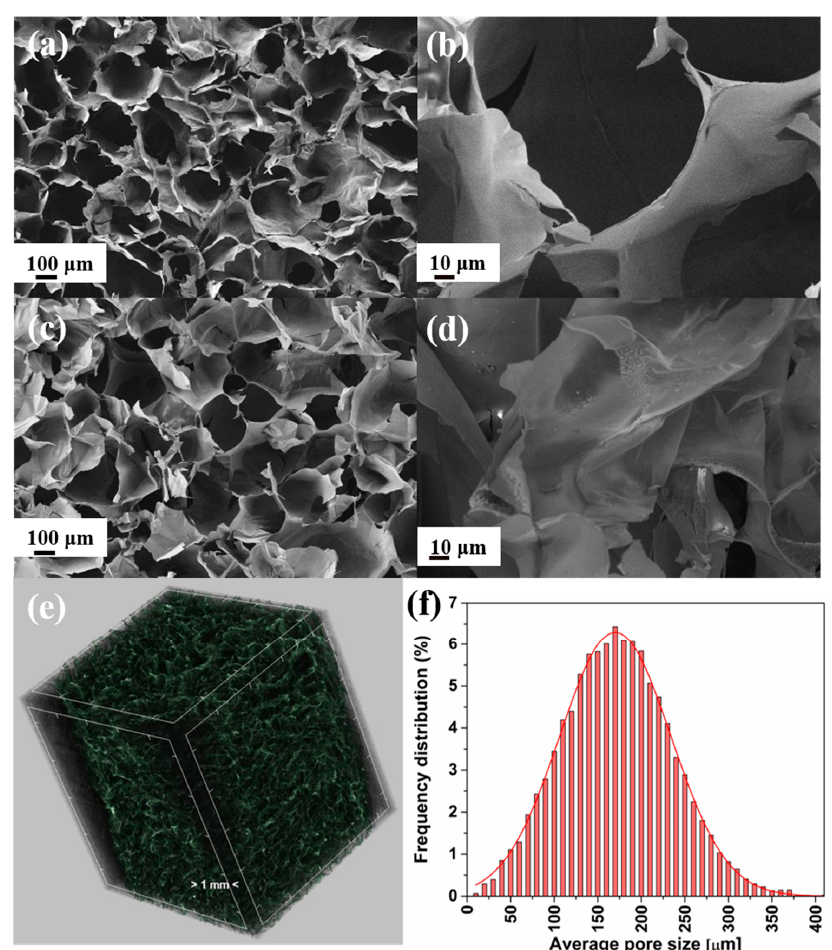
Figure 4. ( a , b ) SEM micrographs of KS sponge and ( c , d ) Ag@KS sponge at different magnifications,